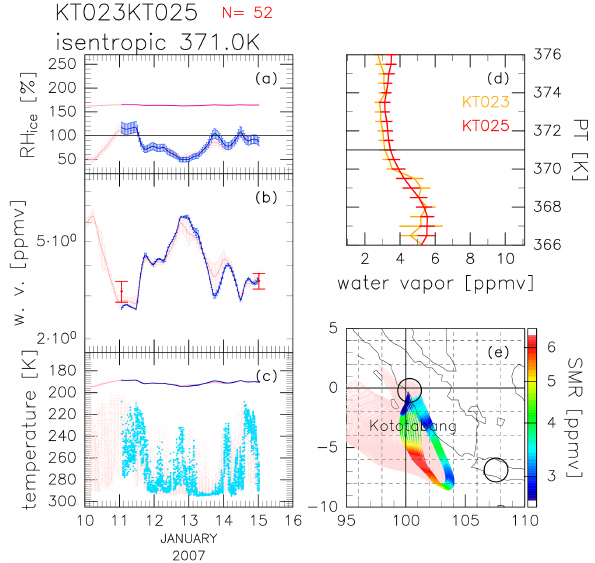
Fig. 5. Meteorological conditions of the match advecting from Ko- totabang (01:42UT, 11 January 2007) to Kototabang (00:37UT, 15 January 2007) on the 371.0K potential temperature surface. Those times correspond to the times of observations, i.e., 50min after each launch (see Sect. 3.2). Vertical profiles of water vapor measured at the first (orange) and second (red) observations, along with esti- mates of errors, are shown in (d) . The figure shows the time evo- lutions of (a) relative humidity over ice (RH ice ) on the assump- tion that the water vapor amount is unchanged from the first mea- surement, along with the uncertainties (blue) and the homogeneous freezing threshold (RH hom ; purple); (b) saturation water vapor mix- ing ratio (SMR; blue line); (c) temperature (blue line) and equiva- lent black body temperature ( T bb ; light blue dots); and (e) trajec- tories of the match air parcel, color coded by SMR history. In (b) , the superposed vertical bars in red are the water vapor mixing ratio measured at the match altitude (horizontal black line in (d) ). Mete- orological data are from ECMWF, and T bb values are derived from MTSAT-1R/GOES-9 IR images. For (a) , (b) , (c) , and (e) each me- teorological value for the match air mass is superposed on that for the whole segments calculated from the circular region centered at the second observation (pink